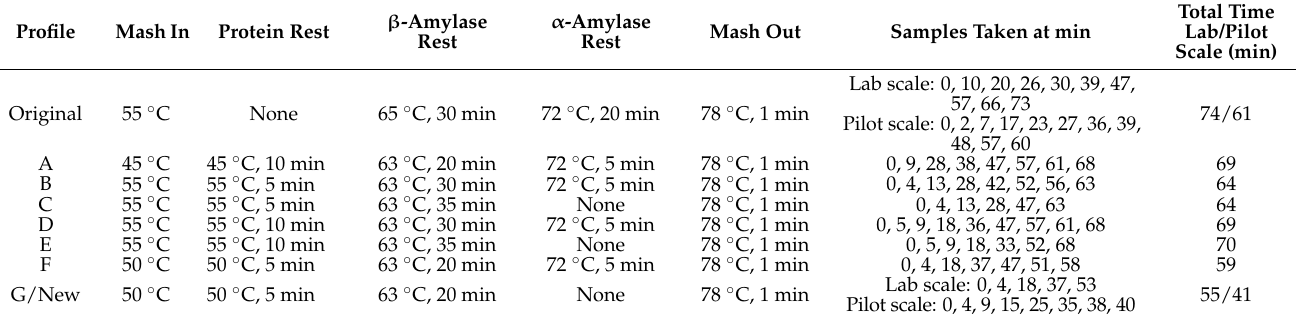
Table 1. Mashing profiles investigated in the present